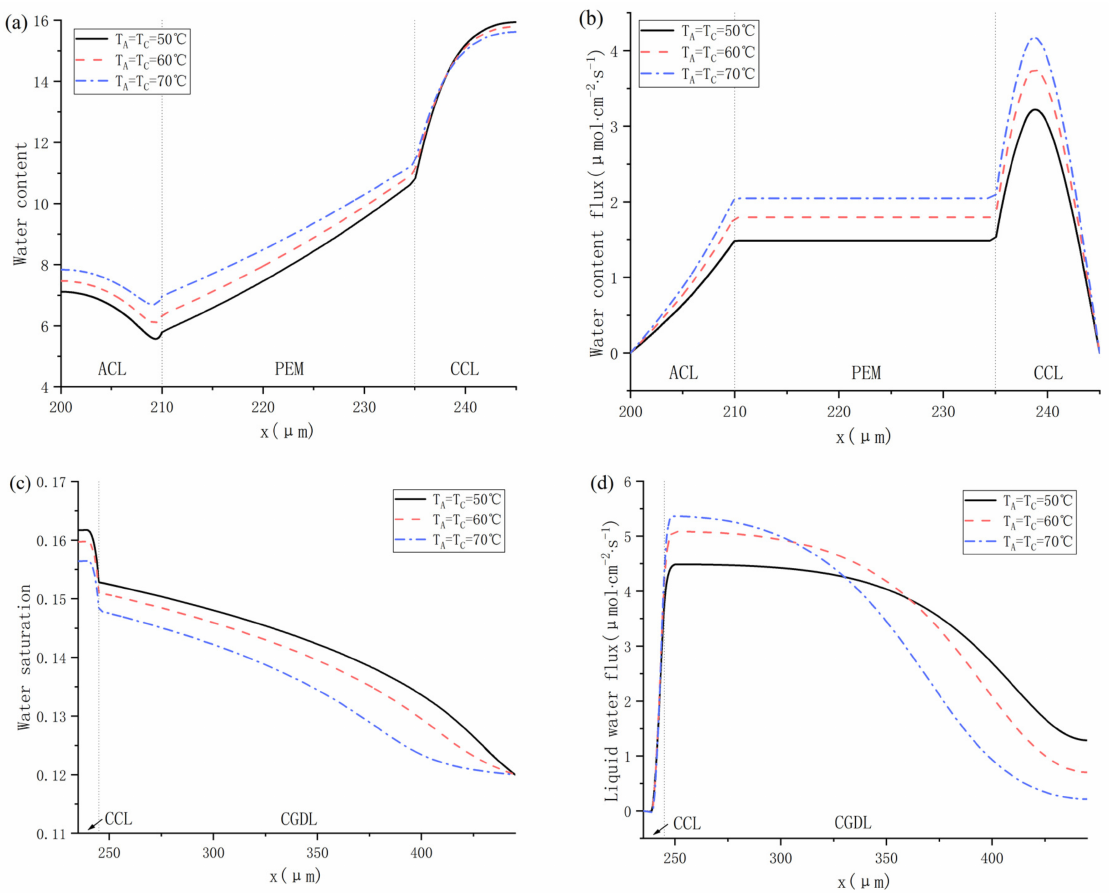
Figure 11. Water distribution under 50 ◦ C, 60 ◦ C and 70 ◦ C: ( a ) water content; ( b ) water content flux; ( c ) water saturation; and ( d ) liquid water